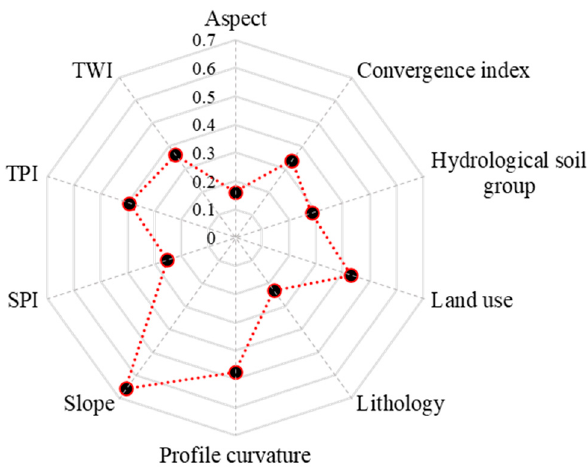
Figure 5. Linear Support Vector Machine (LSVM) scores assigned to flash-flood predictors.